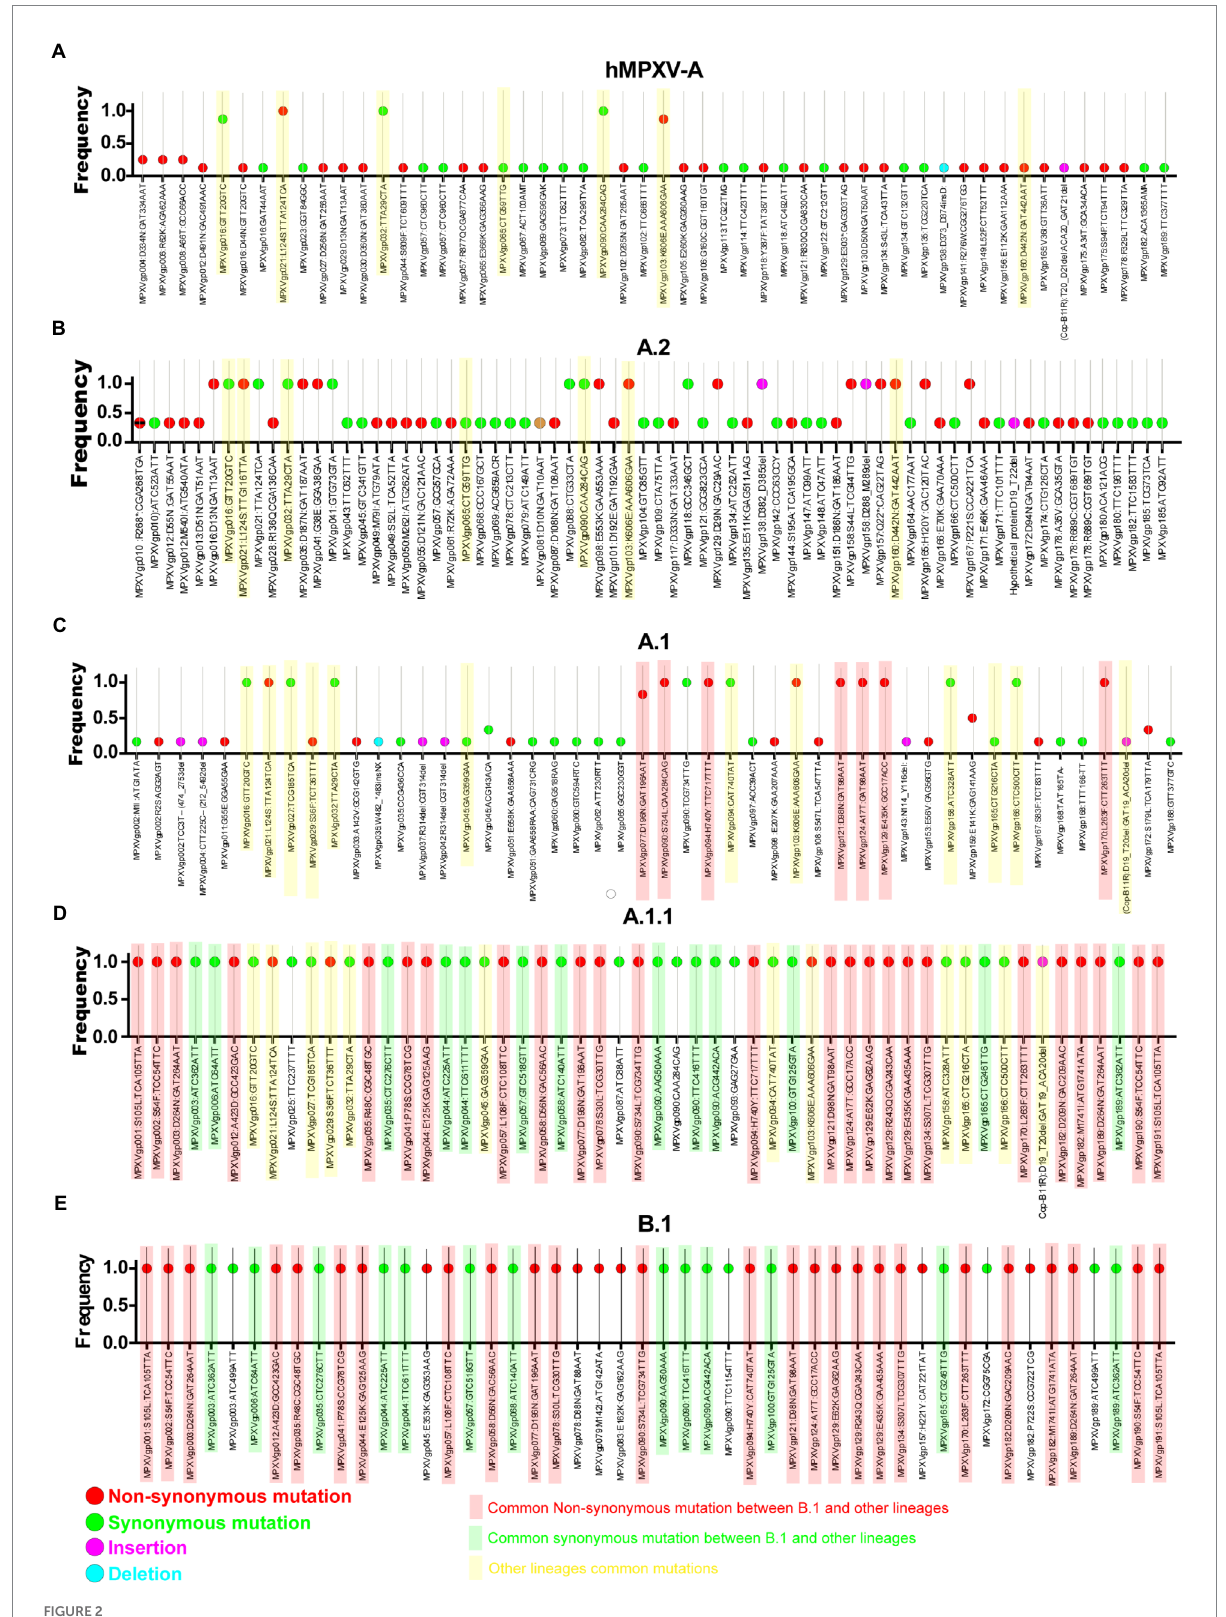
FIGURE 2 Nucleotide and amino acid mutations present in the different lineages of hMPXV (Clade IIb-A, A.2, A.1, A.1.1, and B.1). (A) Nucleotide and amino acid mutations in the Clade IIb-A lineages of viruses (n = 8) compared with NC_063383.1/ MT903340.1. (B) Nucleotide and amino acid